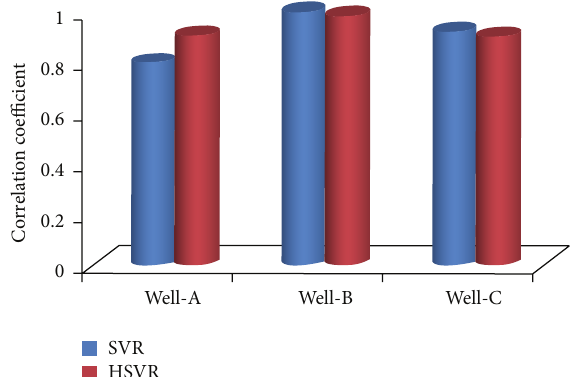
Figure 10: Correlation coefficient for SVR and HSVR (training phase).